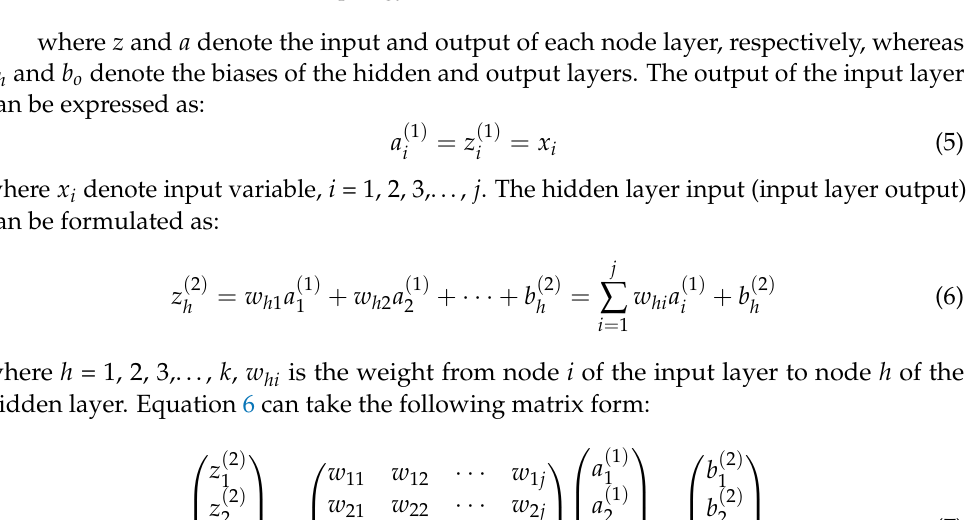
Figure 11. Elman neural network